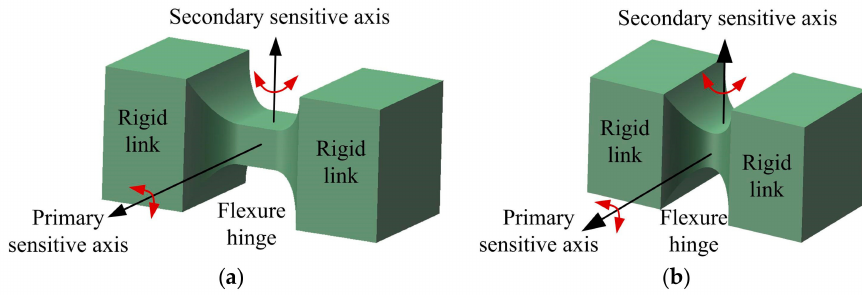
Figure 1. Hinge configurations: ( a ) Two-axis corner-filleted flexure hinge; ( b ) Two-axis flexure